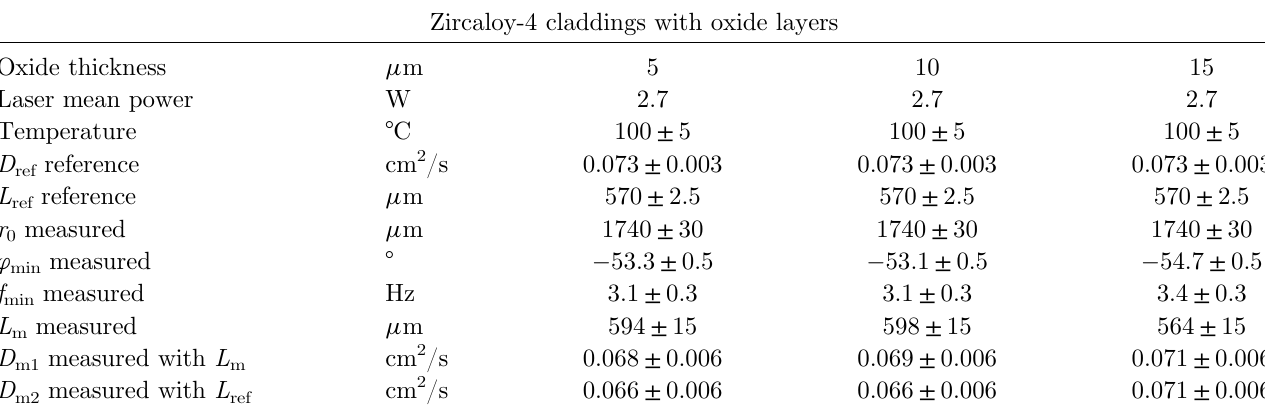
Table 1. Thickness and thermal diffusivity measurements for Zy4 claddings with oxide layers.